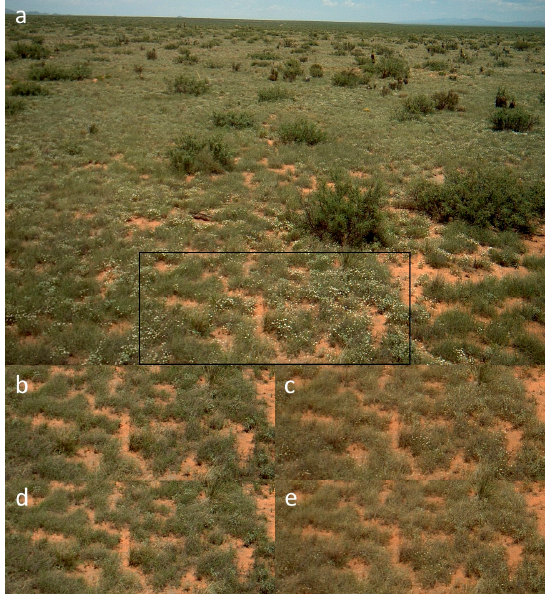
Figure 7. Midday images from the ibp site in 2015; shown are ( a ) the full landscape view, and ( b – e ) a sub-region enlarged to show herbaceous flowering detail; Season Spotter indicated ( a ) mid-season flowering, 2 August; ( b ) no flowering, 18 July; ( d ) first day of flowering, 19 July; ( c ) last day of flowering, 20 August; ( e ) no flowering, 21 August.